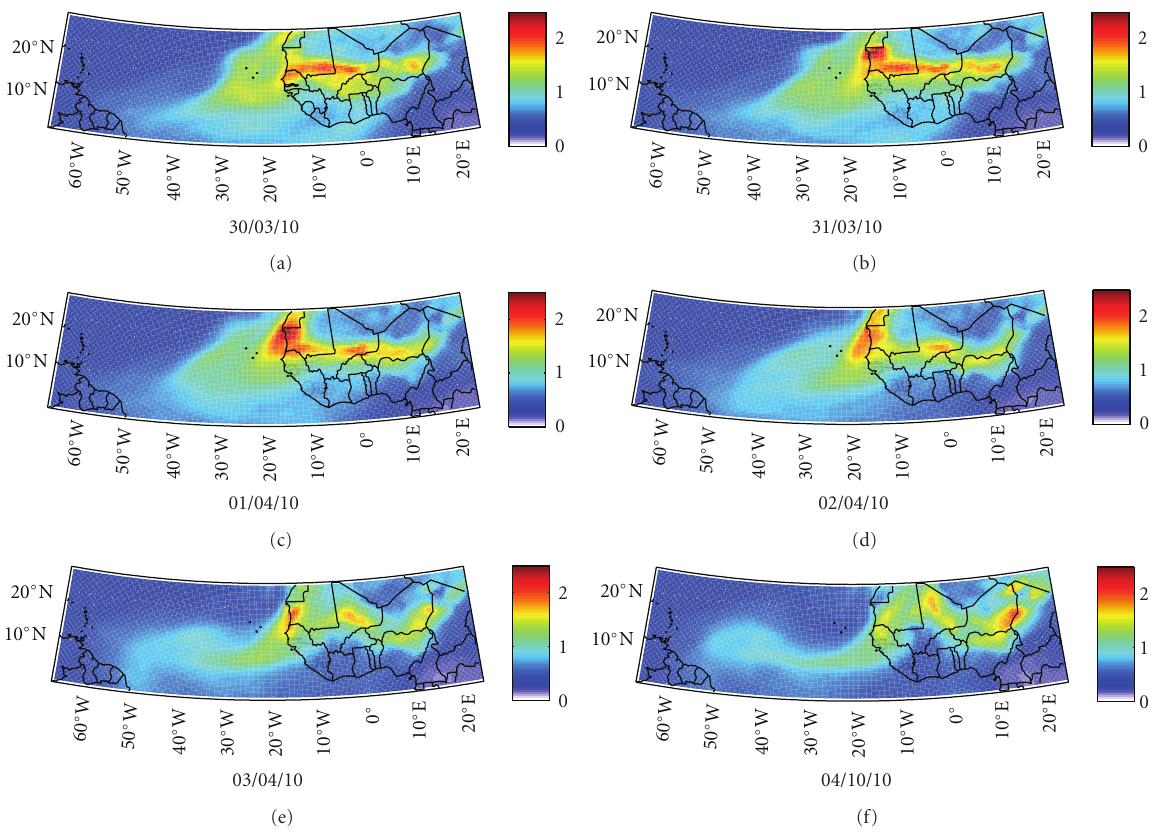
Figure 6: Evolution of dust particles from the African continent to the Atlantic Ocean, simulated with the RegCM 4.0 between March 30th and April 4th 2010.